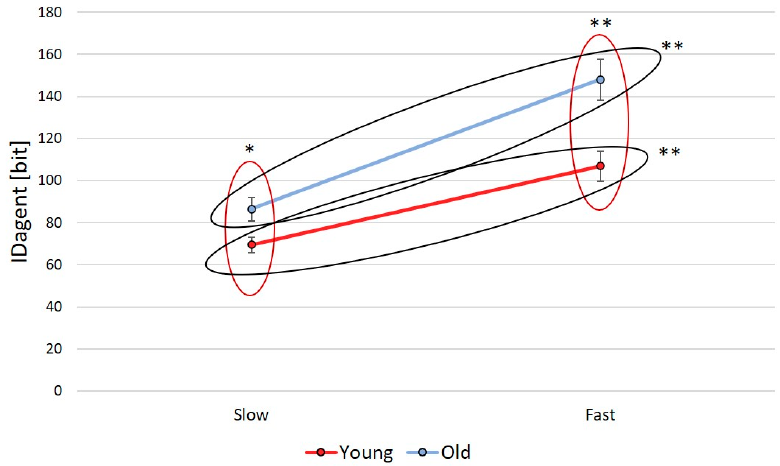
Figure 8. Mean values of ID agent in each group at slow and fast speed conditions. Error bars show SEM (Standard Error of the Mean). Single asterisk indicates significant difference between young and old groups during slow speed condition, p < 0.0125. Double asterisks indicate significant differences across speed conditions for both age groups and a significant difference between young and old groups during fast speed condition, p < 0.002.